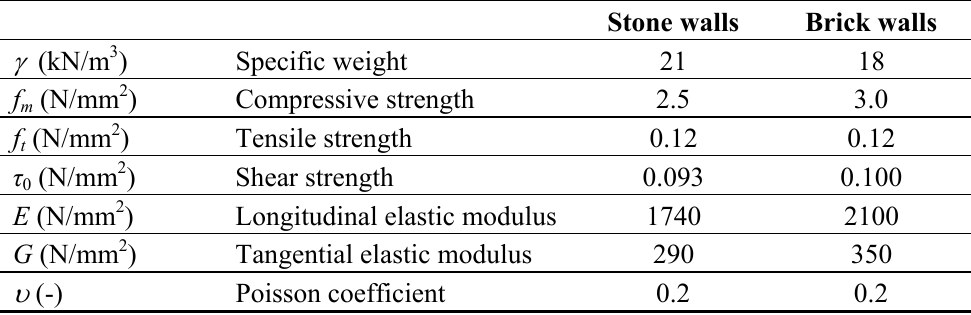
Table 1. Mechanical parameters of the